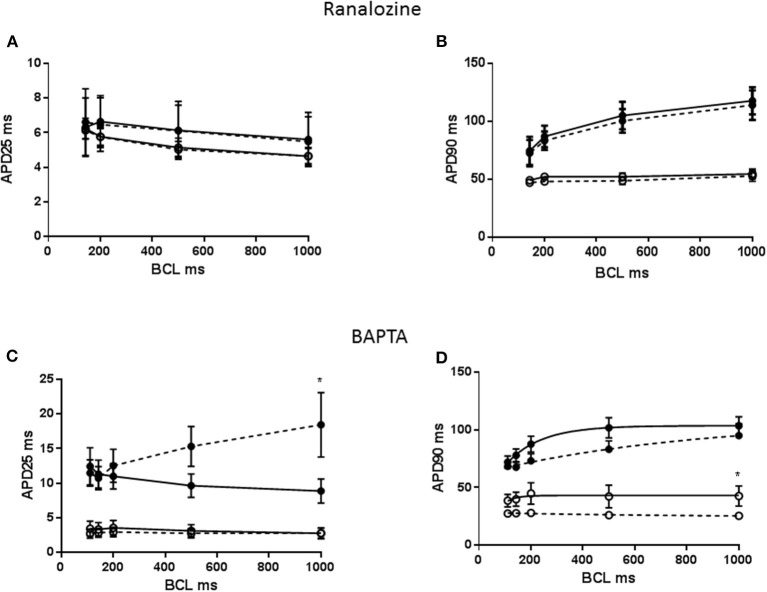
(A) APD25 restitution and (B) APD90 restitution for CON (°) and MCT (•) RV myoctes in the presence (dashed lines) or absence of 5 μM ranolazine. Ranolazine had no effect on APD25 or APD90. (C) APD25 restitution and (D) APD90 restitution for CON (°) and MCT (•) RV myocytes in the presence (dashed lines) or absence of prior exposure to BAPTA. BAPTA lengthened APD25 and reversed the restitution curve in MCT myocytes. In CON myocytes BAPTA reduced APD90 but did not affect APD restitution. n = 6–9 myocytes (A,B), n = 5–6 (C,D). *P < 0.05 vs. ranolazine or BAPTA, two way RM ANOVA.